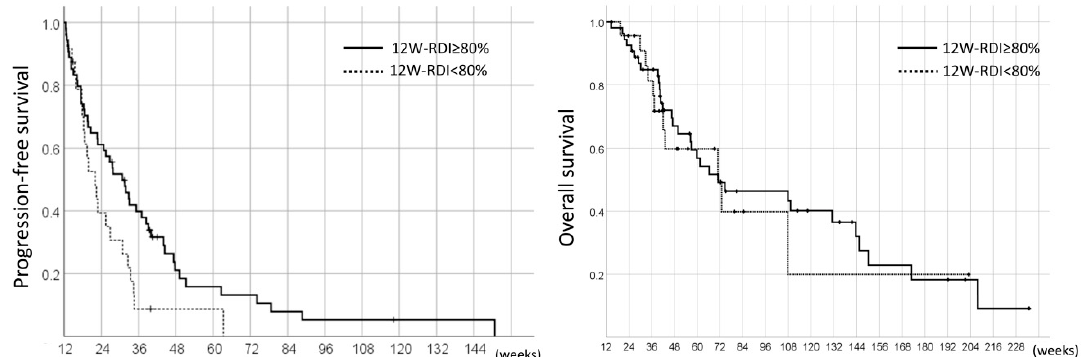
Figure 5. Landmark analysis of PFS and OS in the 78 pazopanib responders by RDI in the initial 12 weeks (12W-RDI).